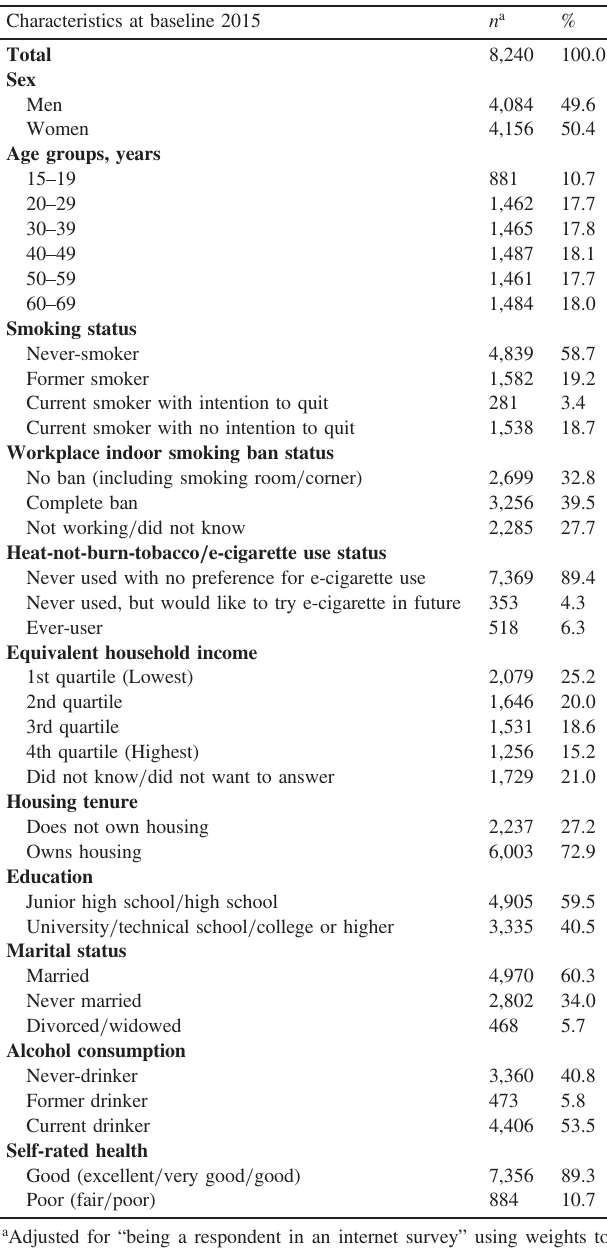
Table 5. Characteristics of baseline study subjects (Cohort 1